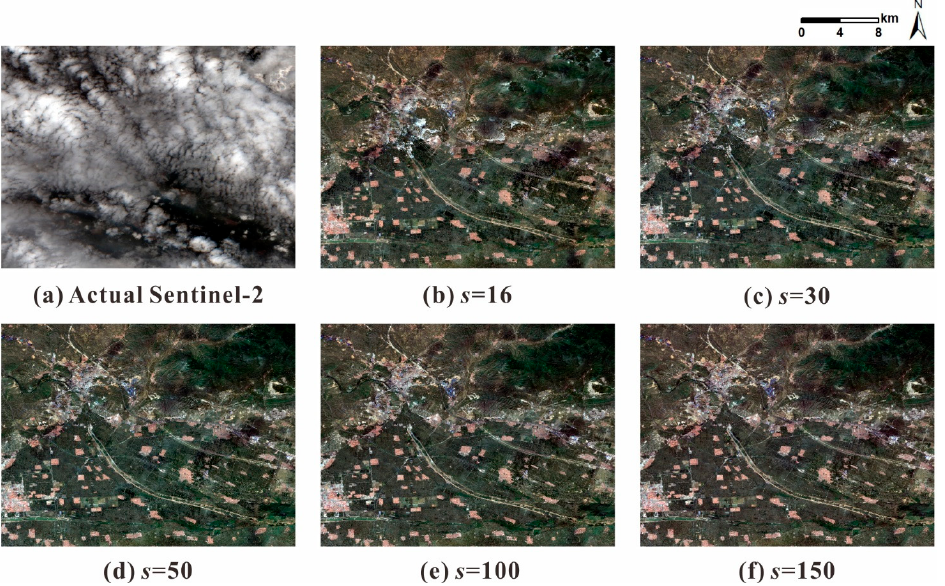
Figure 13. The actually acquired Sentinel-2 image ( a ) in Case 3 situation in Area A (11 July 2020), and reconstructed images ( b – f ) with different values of 𝑠 .